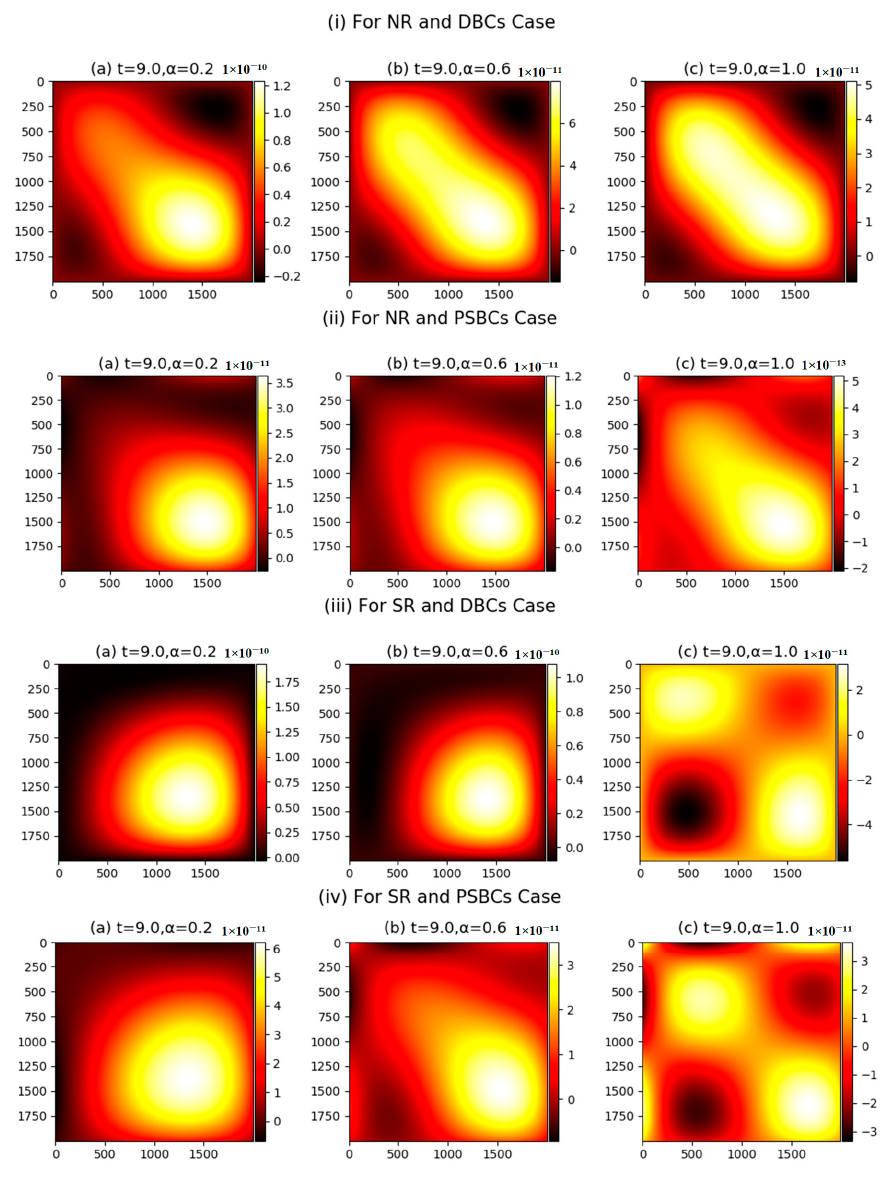
Figure 7. ( i – iv ) Density plots with M 1 = M 2 = M 3 = M 4 = 5, N =